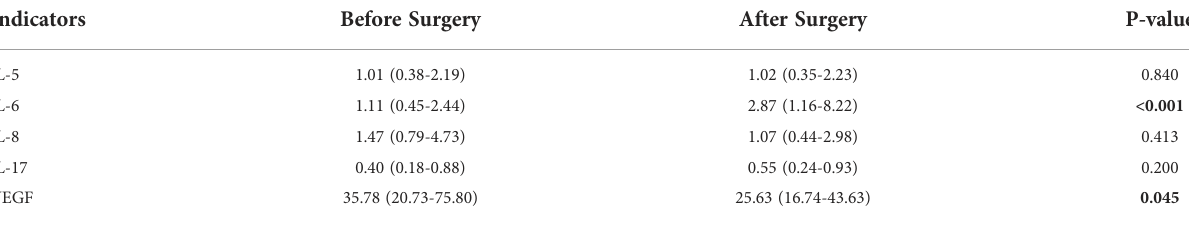
TABLE 6 Comparison of serum IL-5, IL-6, IL-8, IL-17 and VEGF levels in the breast cancer surgery group before and after surgery. Indicators Before